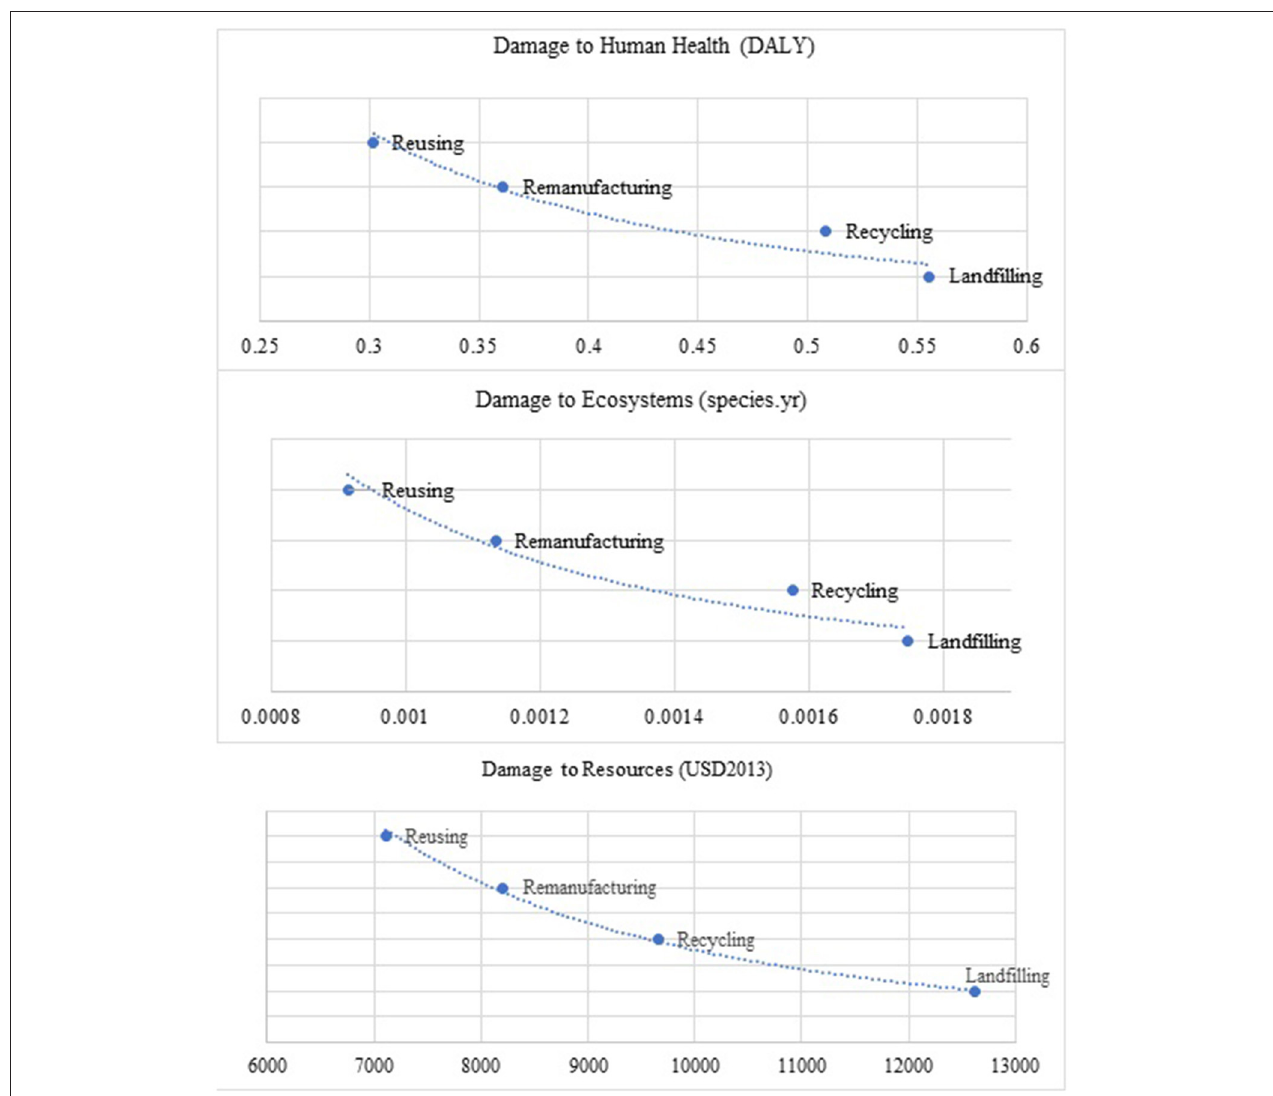
FIGURE 5 | The potential impact of reverse logistics